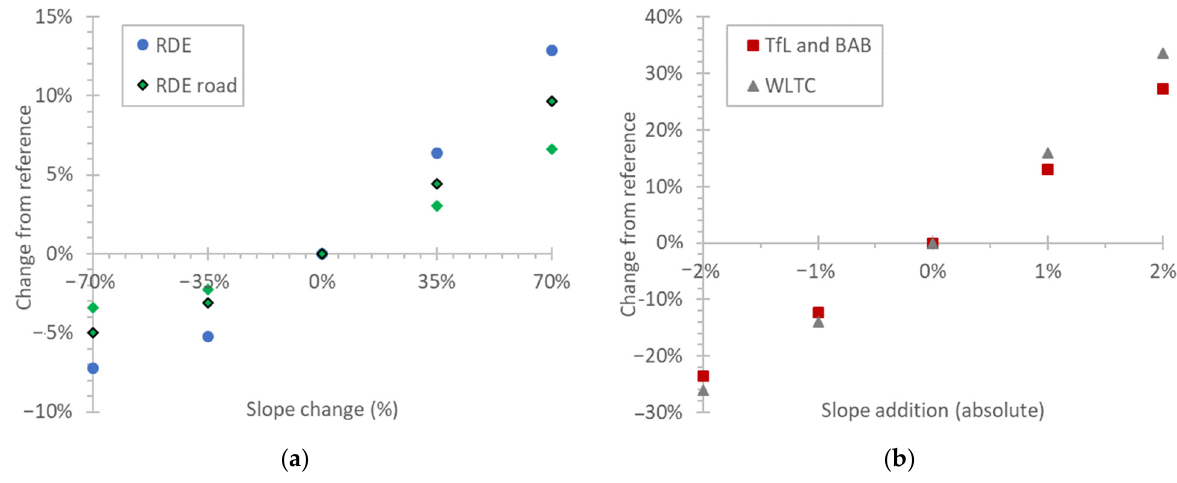
Figure 9. Effect of road slope on CO 2 emissions based on the simulation tool. ( a ) Percentage change of actual road slope; ( b ) addition of slope.